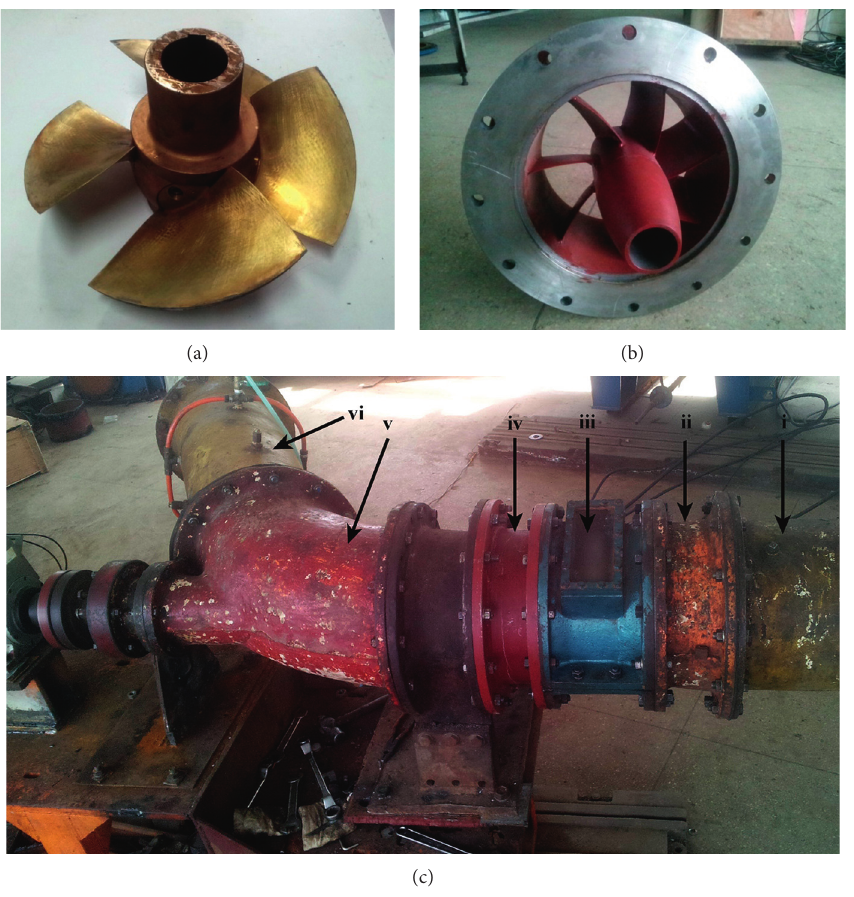
Figure 6: Model device. (a) Impeller. (b) Guide vane. (c) Pump installation with (i) inlet pipe, (ii) inlet cone pipe, (iii) impeller, (iv) guide vane, (v) 60 ° elbow pipe, and (vi) outlet pipe.